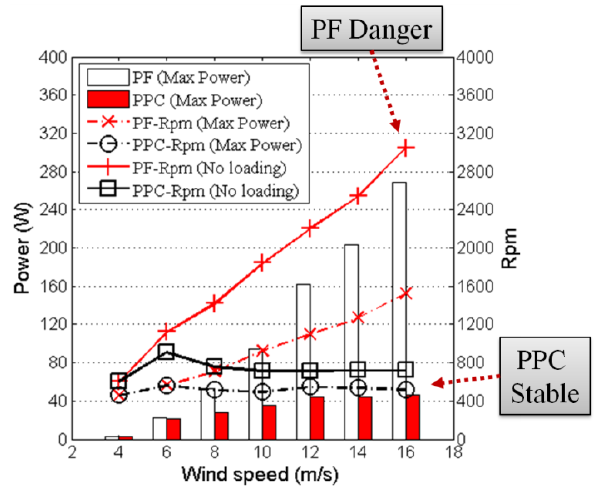
Figure 13. Experiment data of PF and PPC at 4 m/s to 16 m/s.